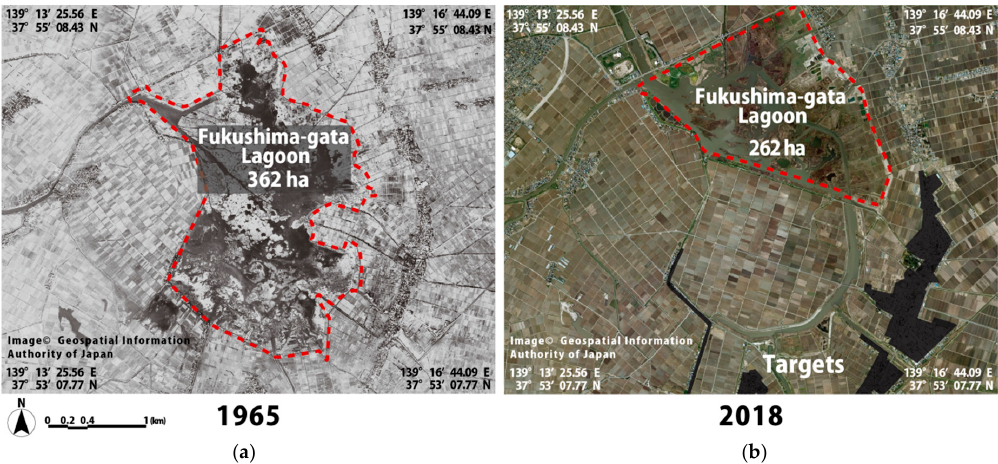
Figure 1. Study area. ( a ): Fukushima-gata lagoon before the reclamation project (1965) [6]; ( b ): Fukushima-gata lagoon after the reclamation project (2018) [6]. Red dotted line: outline of the Fukushima-gata lagoon. The target village (black filled range) made expressions that do not specify villages from ethical consideration .